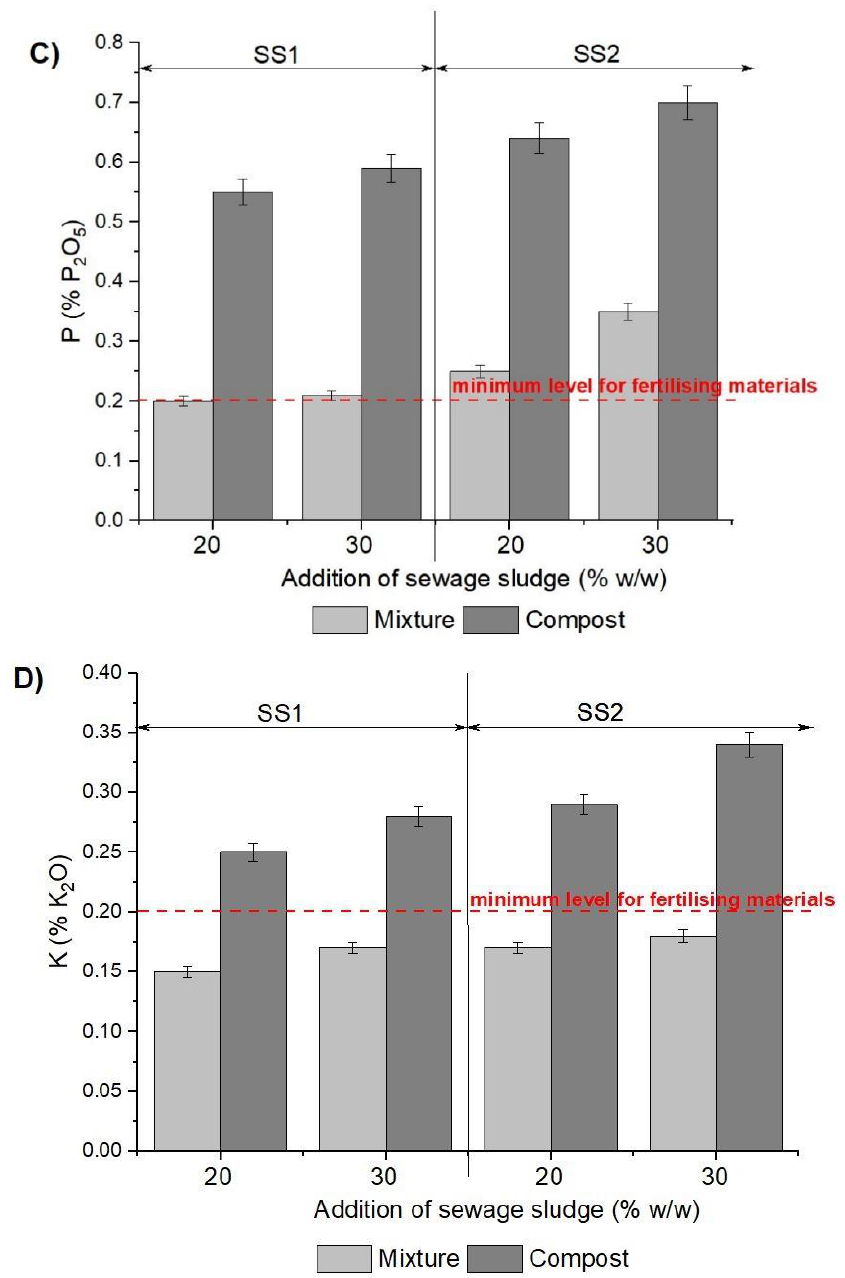
Figure 4. Comparison of organic matter and NPK in mixtures and compost with Polish Regulations requirements in red, where: ( A ) content of volatile solids (%) in the mixture and the compost; ( B ) nitrogen concentration (%) in the initial composting mixtures and final composts; ( C ) phosphorus concentration (%) in the feedstock and final composts; ( D ) the concentration of potassium (%) in the mixture and the compost